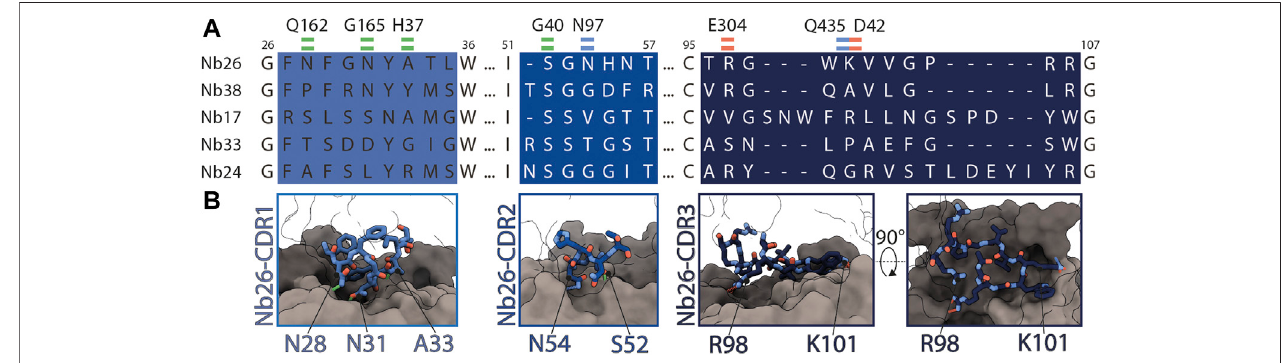
FIGURE 5 | Interactions between Nb26 and DtpC. (A) The sequences of the fi ve nanobodies representing fi ve different families, obtained after selection, with their complementary determining regions (CDR) are shown. Interactions of Nb26 with DtpC are highlighted as green (hydrogen bonds involving the protein backbone), blue (hydrogen bonds involving side chains) and red dashes (salt bridges). (B) These interactions are further displayed in 3D. CDR regions are depicted as sticks on the surface of DtpC where the N-terminal bundle is colored in grey, and the C-terminal bundle in dark grey.